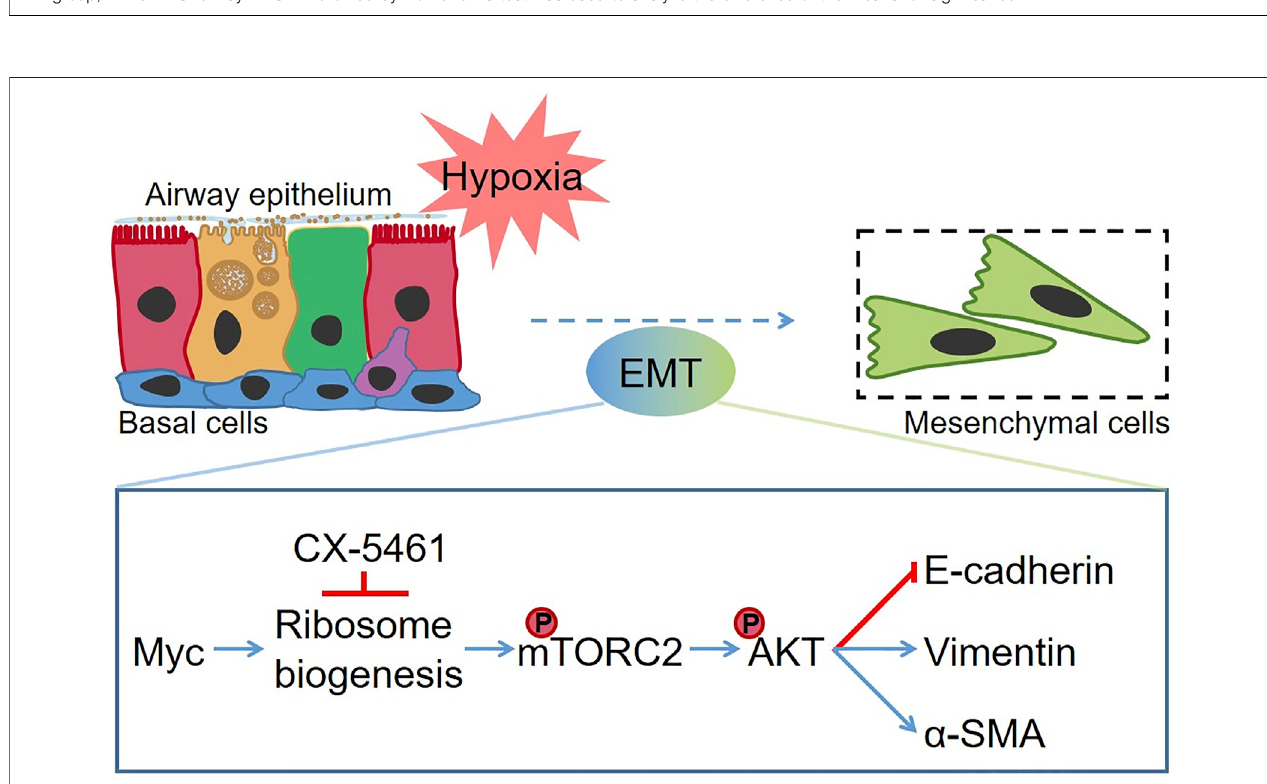
FIGURE 8 | The schematic diagram of hypoxia-induced EMT in MTECs. Hypoxia enhanced the ribosome biogenesis by increasing the expression of Myc. Subsequently, the phosphorylation of mTOR at Ser2481 was upregulated, and phosphorylation of AKT signi fi cantly increased, which promotes the occurrence of the EMTprocess. CX-5461 suppressed hypoxia-induced EMTby inhibiting the ribosome biogenesis. Thered linedenotes the repression effects, and the blue lineindicates the facilitation effect.